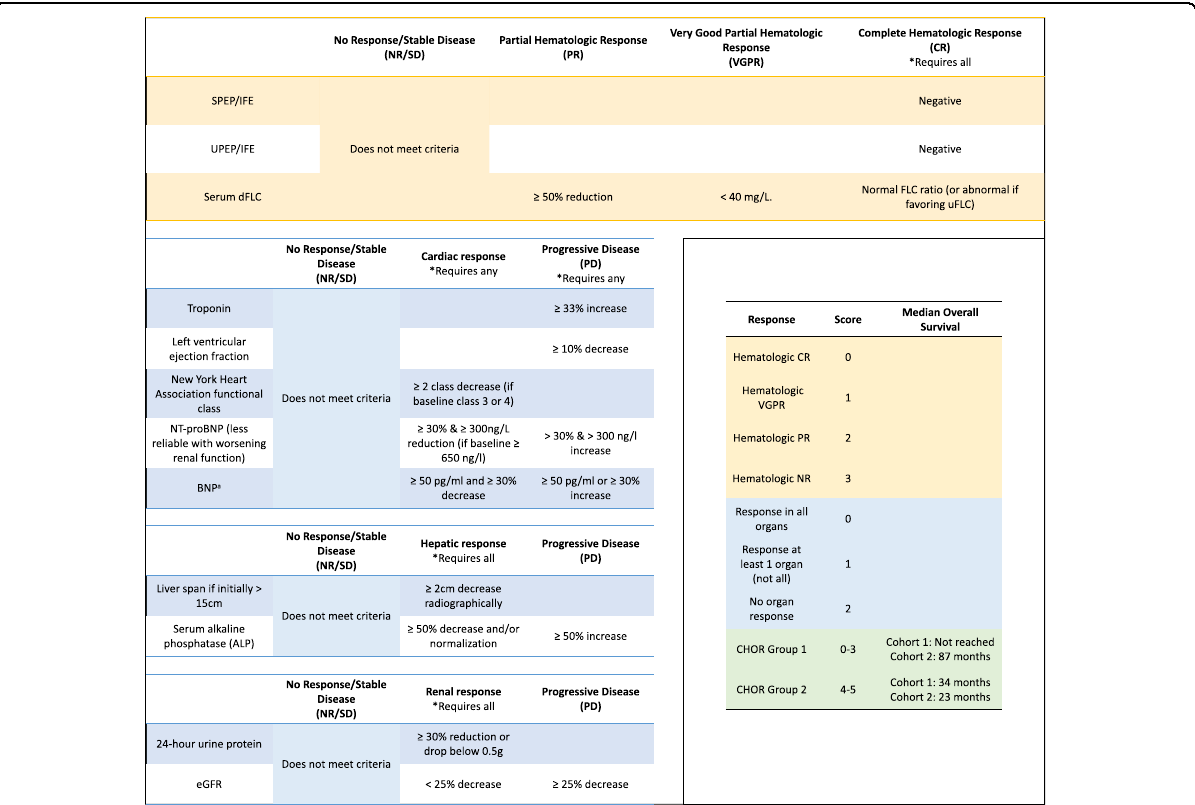
Fig. 3 Criteria for hematologic and organ response in amyloidosis. SPEP/IFE serum protein electrophoresis and immuno fi xation, UPEP/IFE urine protein electrophoresis and immuno fi xation, dFLC delta free light chain, uFLC uninvolved free light chain, eGFR estimated glomerular fi ltration rate, CHOR composite hematologic/organ response model. Response criteria were derived from Palladini et al. J. Clin. Oncol 2012; Comenzo et al. Leukemia 2012; and Palladini et al. Blood 2014. a: New BNP-based cardiac criteria were derived from Lilleness et al. BJH 2020. CHOR scoring model derived from Sidana et al. Blood Cancer Journal